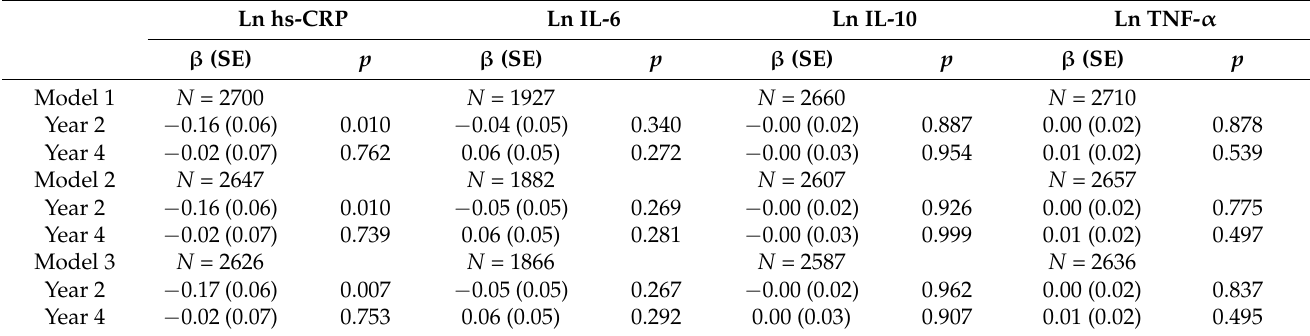
Table 2. Effects of vitamin D 3 supplementation on log-transformed inflammatory markers.